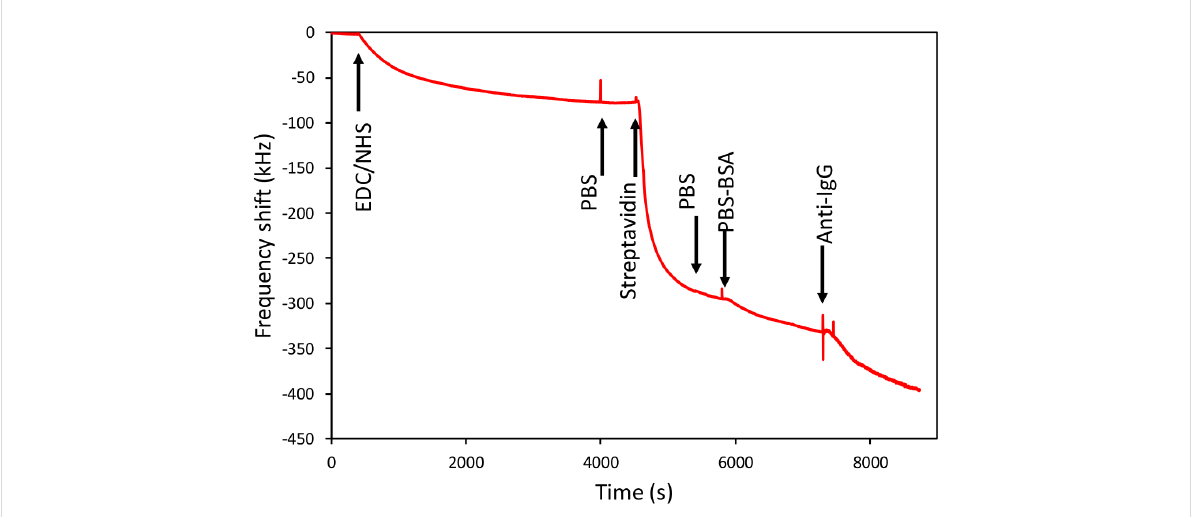
Figure 6: Resonant frequency evolution of a resonator during the covalent functionalization and anti-IgG antibody detection process. The arrows indi- cate the moments at what the liquids are changed.